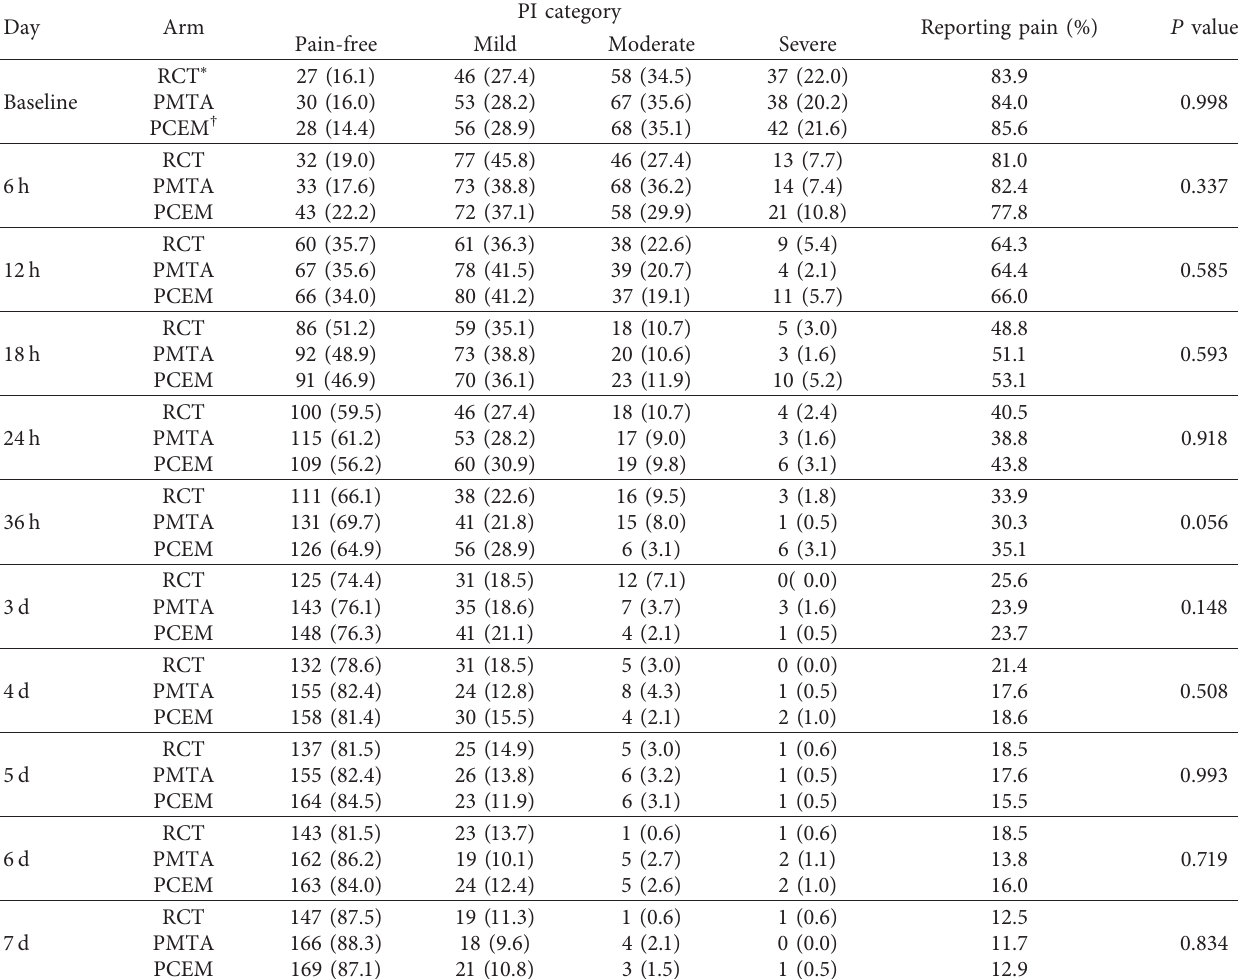
Figure 2: Pain intensities during the study in the RCT, PMTA, and PCEM arms. Table 5: Frequency distribution of pain severities [ N (%)] during 7 postoperative days in the three study